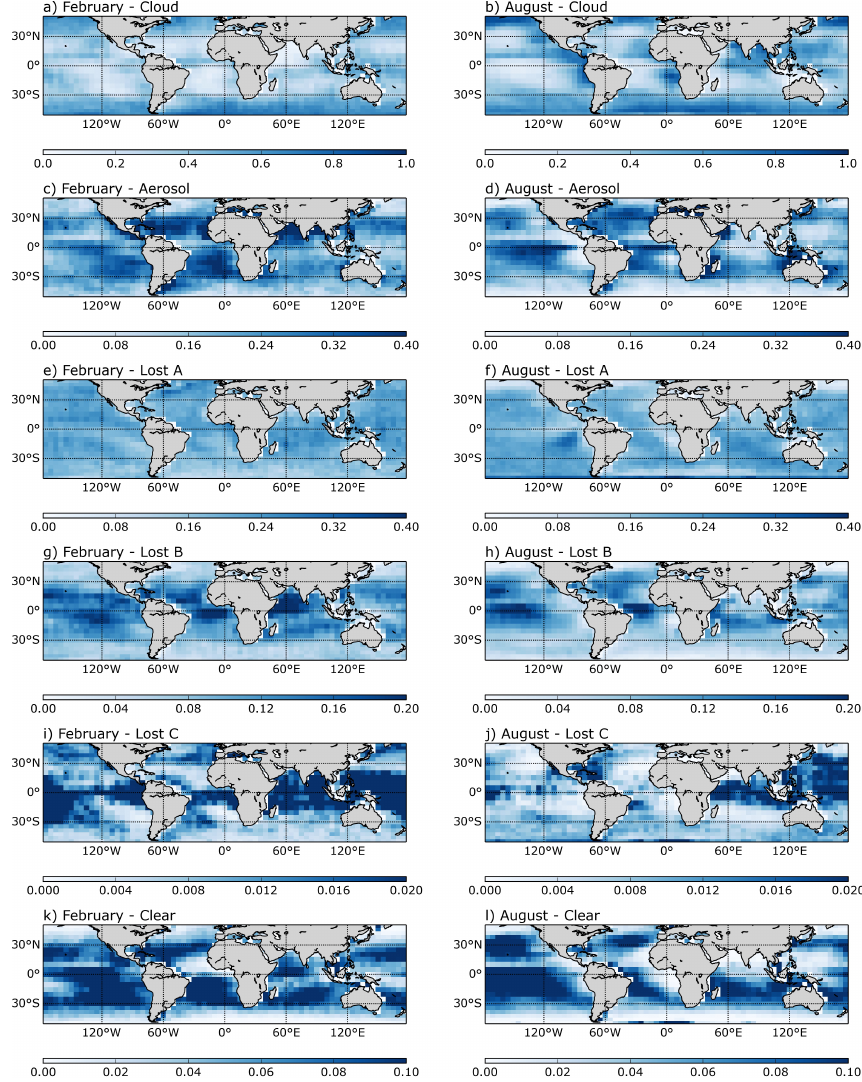
Figure 4. Occurence frequencies of each class (colormaps are fitted to the range of values of each